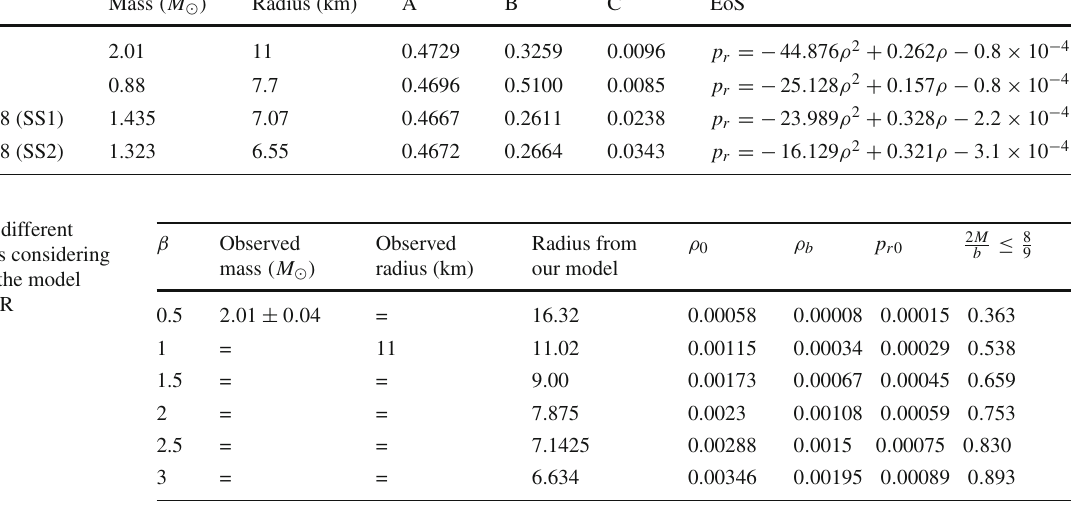
Table 1 Parameter values for different known compact objects with α = 0 . 4 and β = 1 Name of the star